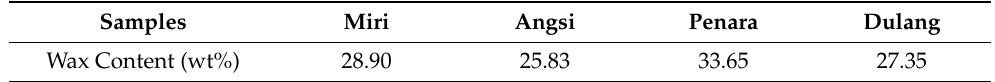
Table 2. Wax content for each